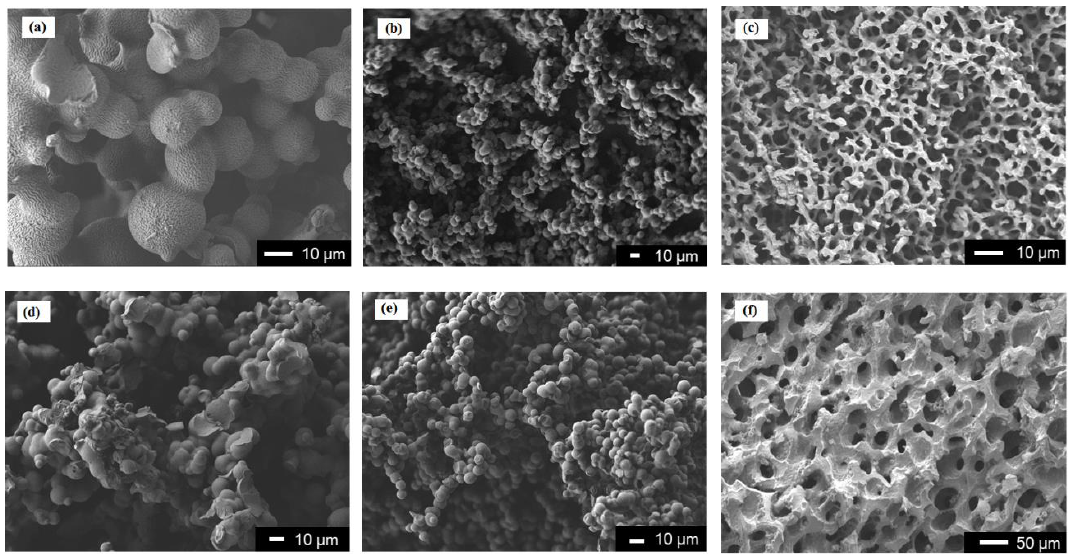
Figure 8. Scanning electron microscopy (SEM) images of ( a – c ) PEI-PEGDA200 and ( d – f ) DETA-PEGDA200 dry porous polymers; monomer concentration in the reaction system: ( a , d ) 20 wt%, ( b , e ) 25 wt%, and ( c , f ) 30 wt%; feed molar ratio of PEI/PEGDA200: 2/14, DETA/PEGDA200: 2/5.